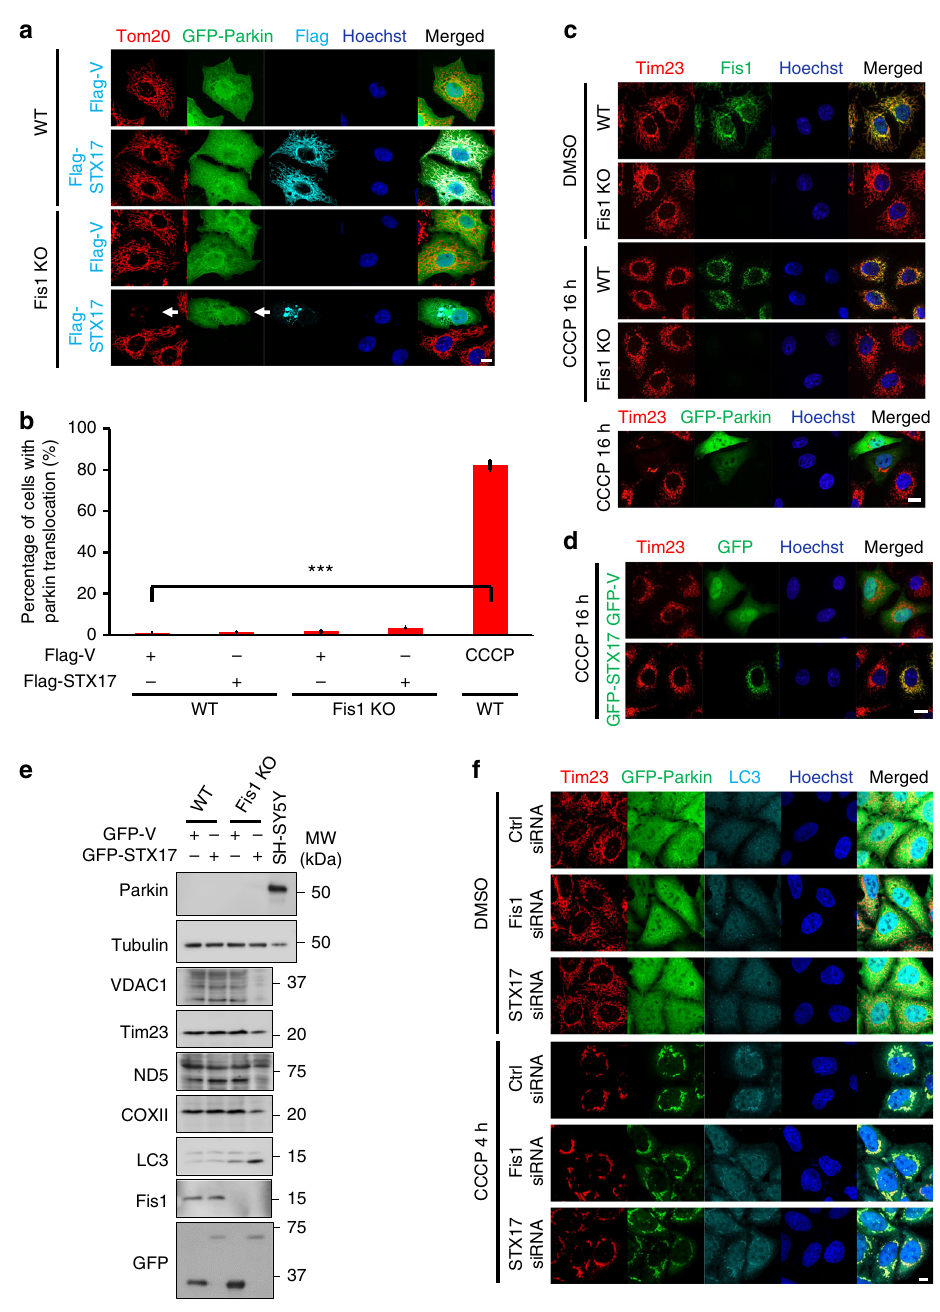
Fig. 3 Syntaxin 17 (STX17)-induced mitophagy is PINK/Parkin-independent. a Wild-type ( WT ) or mitochondrial fi ssion 1 protein knockout ( Fis1 KO ) HeLa cells were transfected with Flag-tagged vector or STX17 and green fl uorescent protein (GFP)-tagged Parkin (green) for 24 h. Cells were analyzed by immuno fl uorescence microscopy using antibodies against Tom20 (red) and Flag (cyan). Hoechst, blue. Scale bar, 10 µ m. White arrow indicates cell with STX17 overexpression-mediated mitophagy. b Bar chart shows the percentage of cells with Parkin translocation as indicated in a . Parkin translocation upon carbonyl cyanide 3-chlorophenylhydrazone (CCCP) treatment at 10 µ M for 4 h was quanti fi ed as positive control. Data are mean ± SD ( n = 150 cells from three independent experiments). *** P < 0.001 (two-tailed unpaired Student ’ s t test). c WT or Fis1 KO HeLa cells were incubated with dimethyl sulfoxide (DMSO) or 10 µ M CCCP for 16 h and then fi xed and immunostained for Tim23 (red) and Fis1 (green). Cells transiently expressing GFP-tagged Parkin and treated with 10 µ M CCCP for 16 h were used as a positive control for mitophagy. Hoechst, blue. Scale bar, 10 µ m. d HeLa cells expressing GFP-tagged vector or STX17 were treated with 10 µ M CCCP for 16 h and immunostained for Tim23 (red). Hoechst, blue. Scale bar, 10 µ m. e WT or Fis1 KO HeLa cells were transfected with GFP-tagged vector or STX17 for 72 h. SH-SY5Y cell lysate was used as the positive control for the expression of endogenous Parkin. Cell lysates were immunoblotted for Parkin and mitochondrial proteins. f HeLa cells stably expressing GFP-Parkin (green) were transfected with small interfering RNA (siRNA) against control, Fis1 or STX17 for 48 h. Then, cells were treated with or without 10 µ M CCCP for further 4 h. Cells were visualized by immunostaining for Tim23 (red) and LC3 (cyan). Hoechst, blue. Scale bar, 10 µ